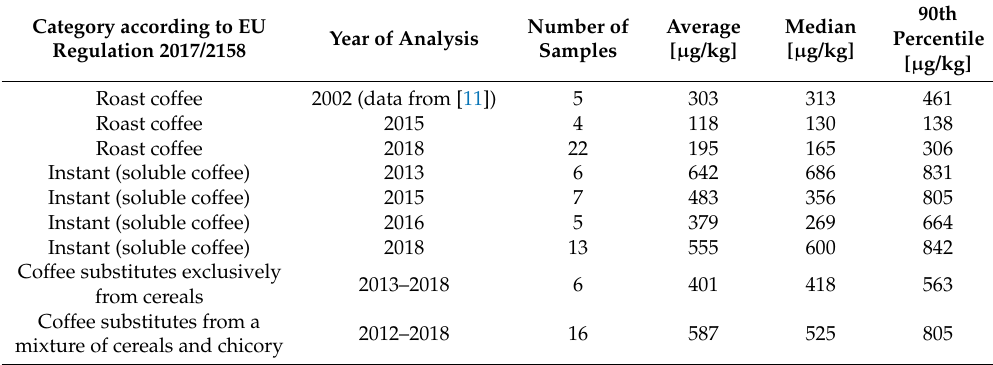
Table 2. Comparison of acrylamide analysis results from 2002 with current results (summary from Annex A, Table